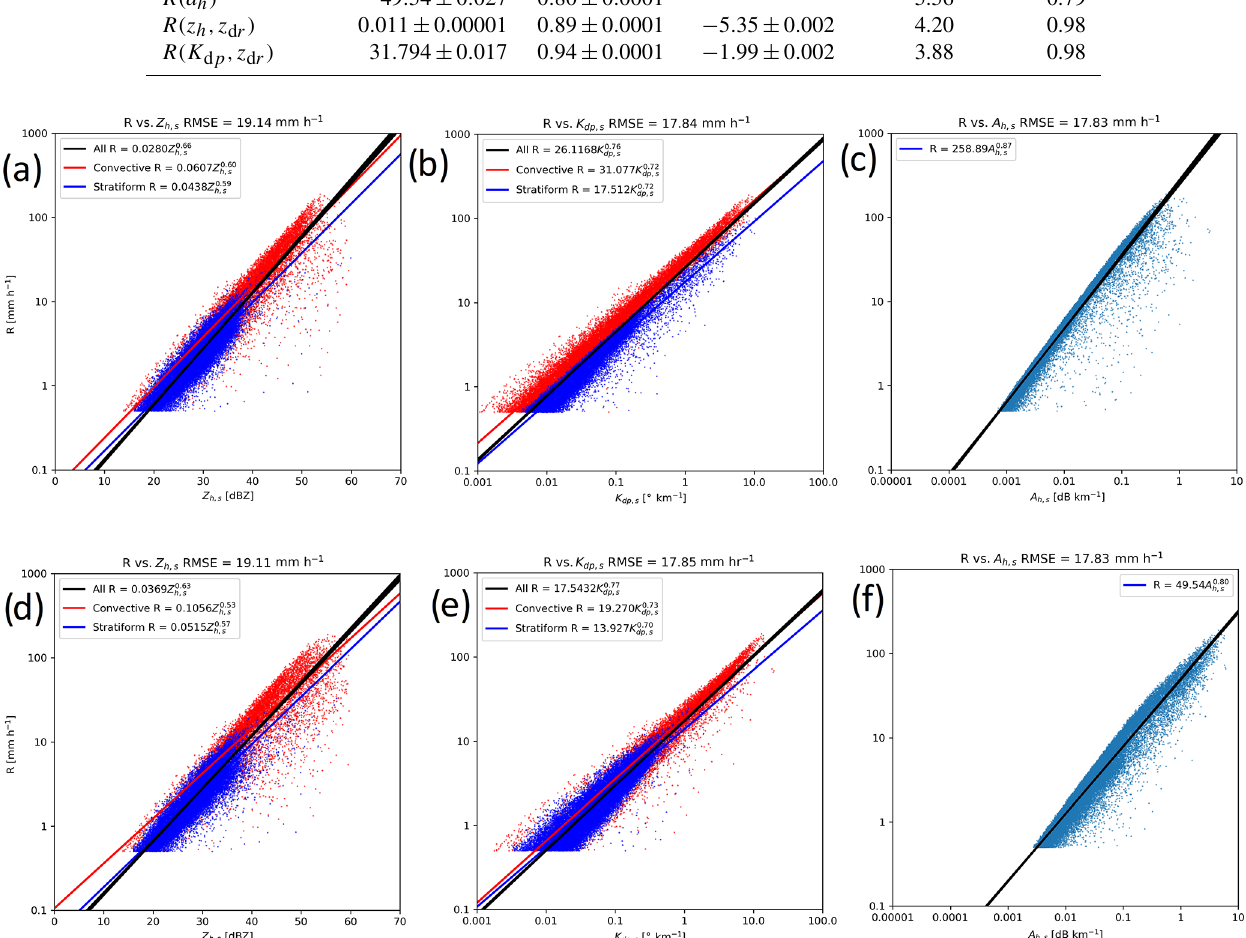
Figure 4. R from VDIS as a function of (a) Z h , (b) A h , and (c) K d p , for the simulated radar moments from VDIS at the C-band. Panels (d–f) are as in (a–c) but for the X-band. Each colored line represents a power-law best fit of the variables. Each black line represents a fit produced by the bootstrap technique applied to the data in each